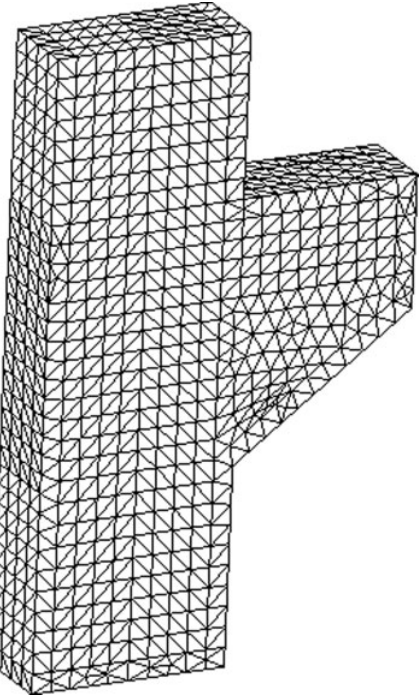
Fig. 5. FE model for a quarter of a corbel Fig. 6. Load – de fl ection curves series